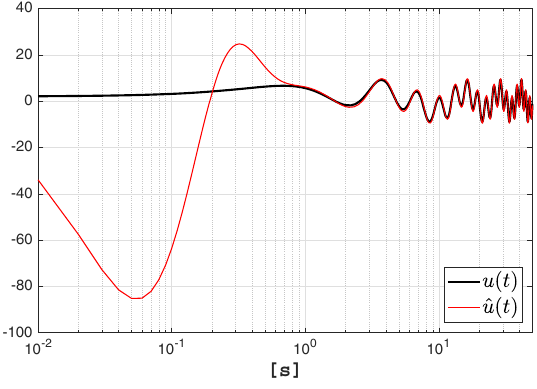
Figure 10. Example 5. Force